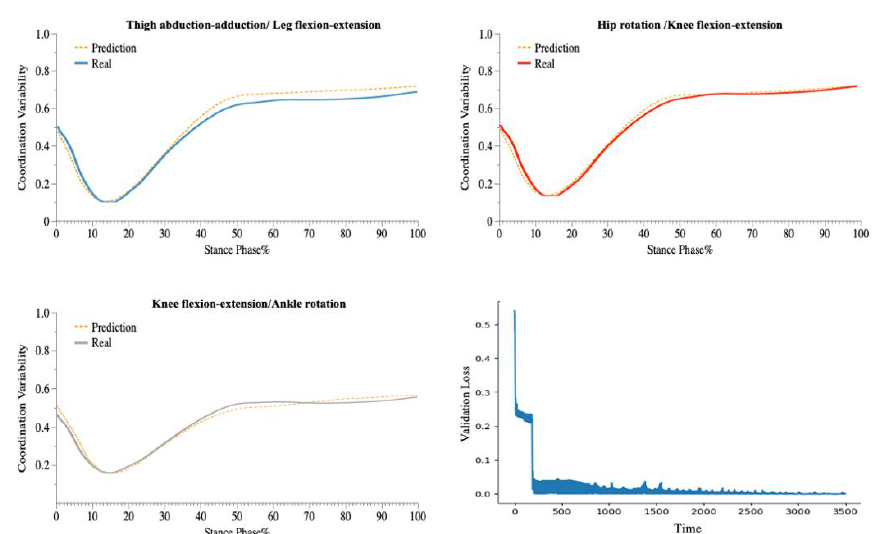
Figure 7. Predicted and Validation Loss Curve for the Coordination of Three Couplings during 180° CM.